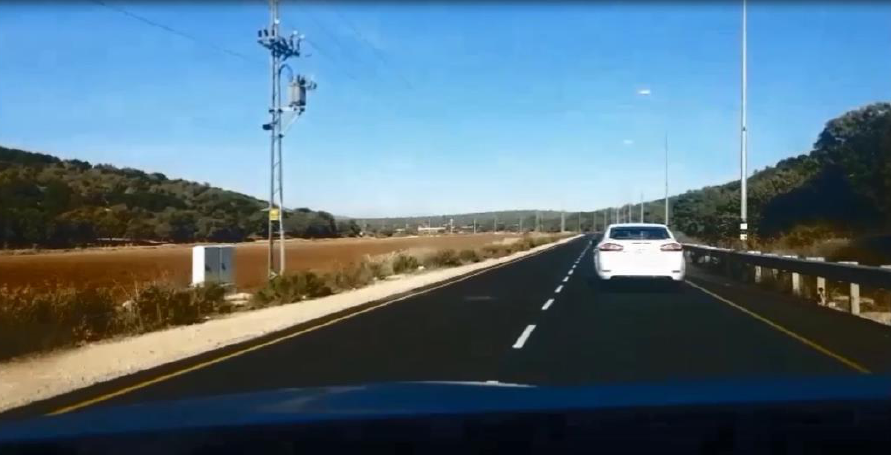
Figure 1. Screenshot of the first overtake situation